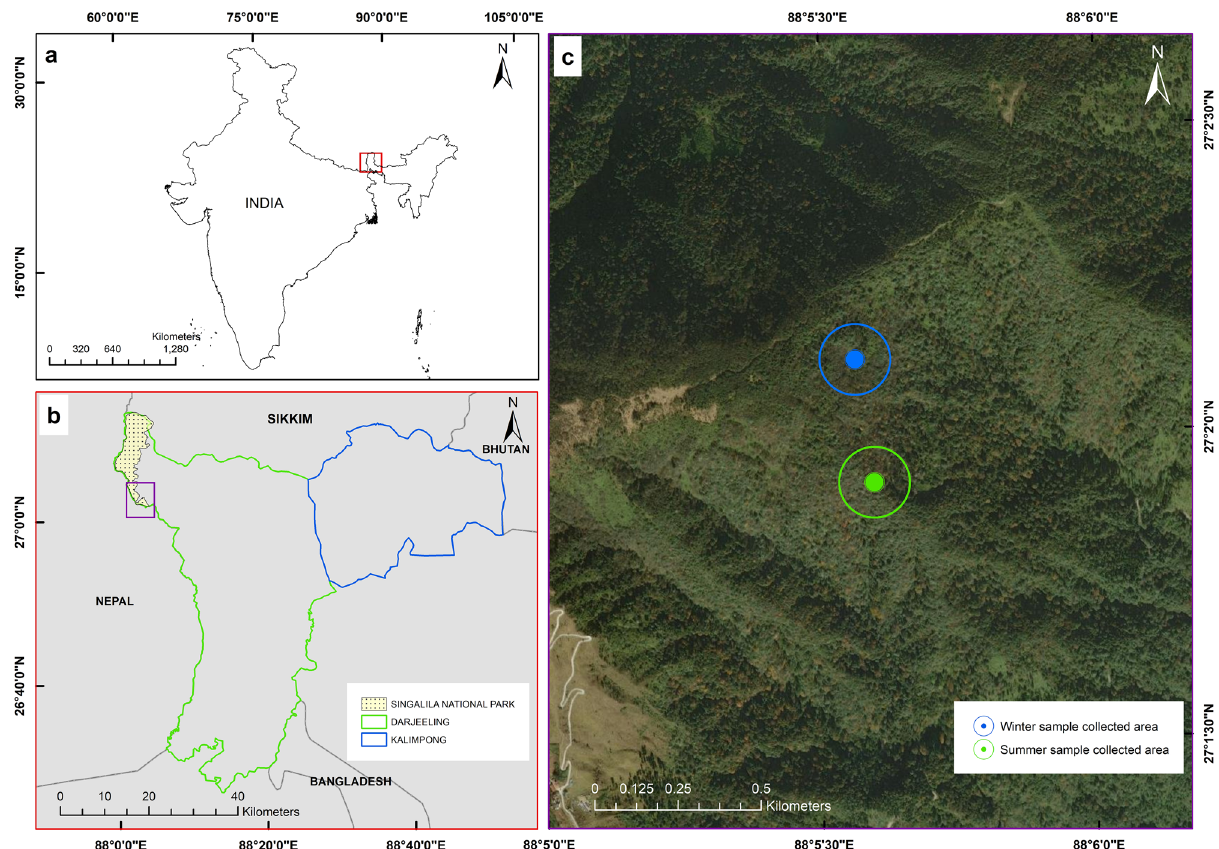
Figure 1. Map compilation showing. ( a) Darjeeling and Sikkim Himalaya in India (red box), ( b) outline of Darjeeling Himalaya with Singalila national park, ( c) expanded view of the sampling site. Map prepared using ArcGIS Desktop 10.5.0.6491 software licensed (2017–2018) to Botanical Survey of India count) are dominant followed by ferns (16.4%) and non-arboreal taxa (5.9%). Among the local arboreal taxa, Betula , Quercus , Arecaceae, Ligustrum , and Rhododendron are represented in significant amounts and vary be- tween 1.9% and 17.9%. Bambusoidae pollen is found to vary between 2.3 and 3.1%. Among the non-arboreal taxa, Artemisia , Malvaceae, and Asteroideae constitute about 0.8–3.7%. Fern and fern allies vary between 4.9 and 11.6% in the palynoassemblages (Fig. 2).